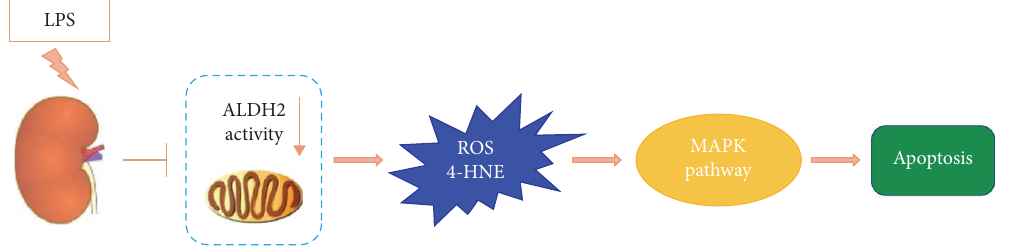
F IGURE 7: Proposed schema of effect of ALDH2 on the LPS-induced septic AKI, involving the inhibition of ALDH2 activity, promotion of ROS and 4-HNE generation, upregulation of MAPK pathway, and resulting in renal cell